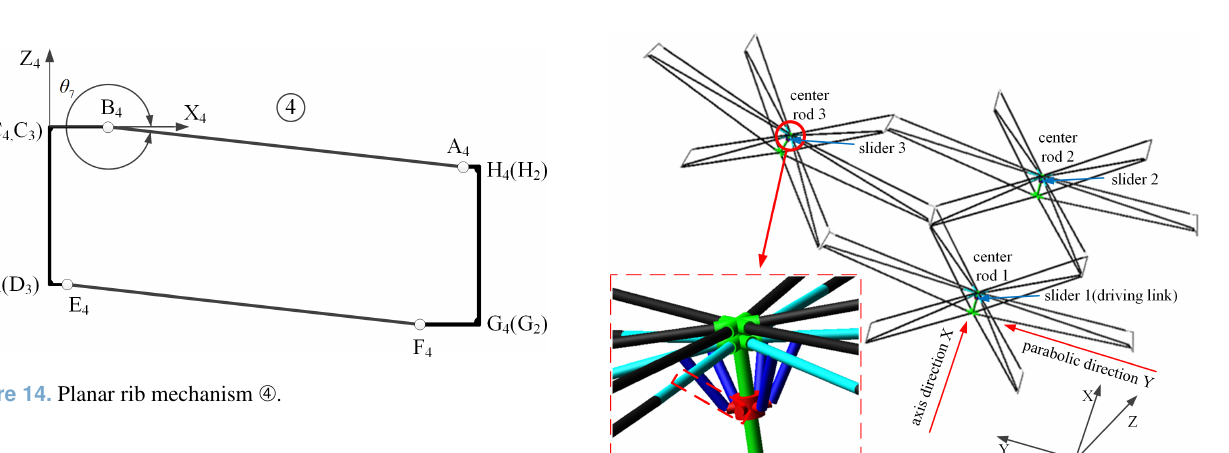
Figure 13. Planar rib mechanism (cid:194) .